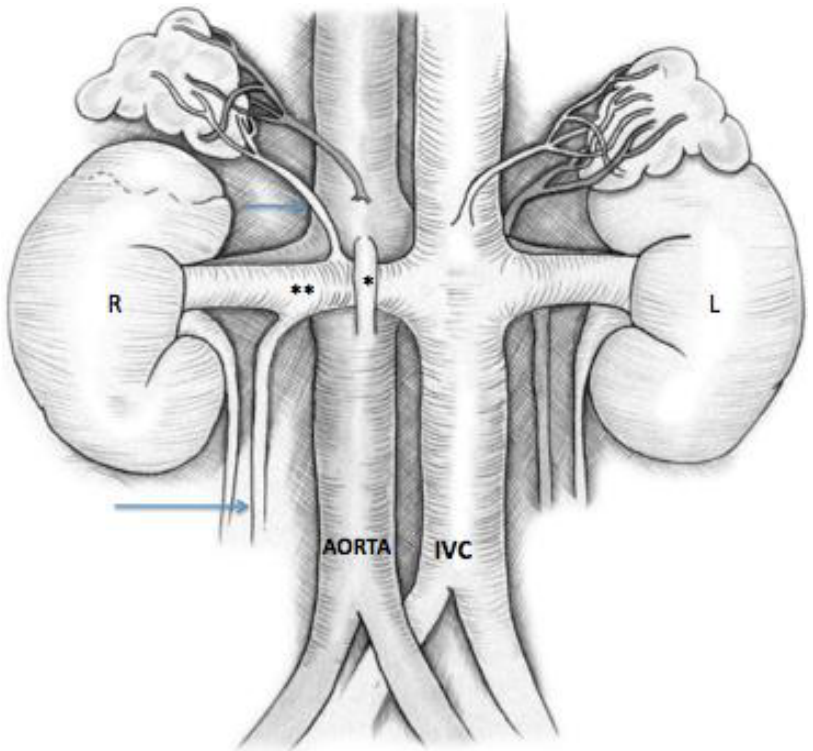
FIGURE 2. Schematic illustration of the patient’s anomalous anatomy. Short arrow = right adrenal vein, long arrow = right gonadal vein, ** = right renal vein, * = superior mesenteric